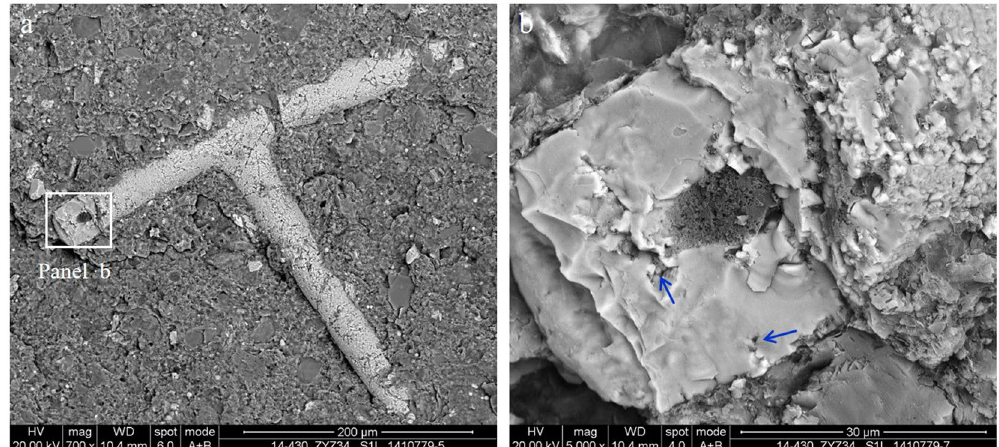
Figure 9. Sponge spicule and the related pores of the Longmaxi Formation in well Jiaoye 2 (2556.91 m). ( a ) Sponge spicule. ( b ) The bitumen with pores in the sponge spicule (cross section) and pores within walls (blue